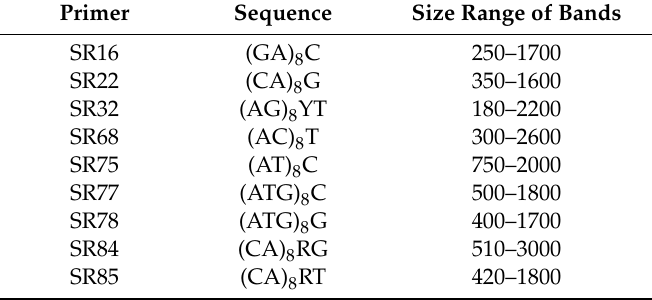
Table 1. Inter-simple sequence repeat (ISSR) primers used for analysis with range of band sizes.